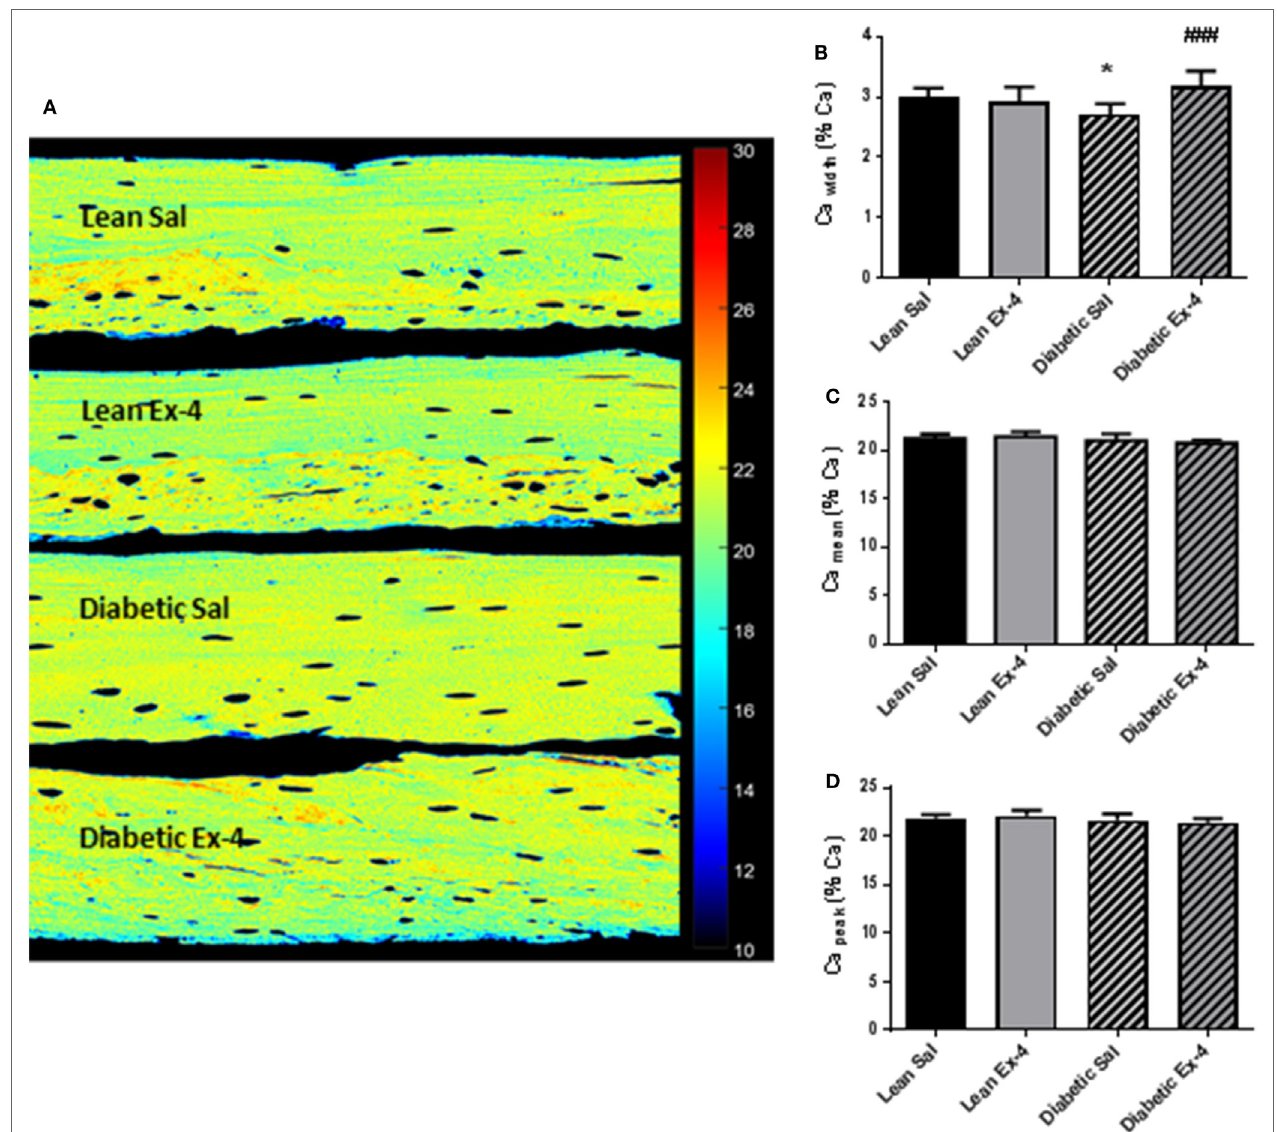
FigUre 6 | Effect of Exenatide on bone mineral density distribution (BMDD) in db/db and control mice. Quantitative backscattered electron imaging was employed to determine the BMDD in tibial methylmethacrylate-embedded blocks from 13-week-old db/db and lean mice treated with either Exenatide (10 μ g/kg/day) or saline. (a) Representative calcium (Ca) map. (B) Characterization of BMDD by Ca width. (c) Characterization of BMDD by Ca mean. (D) Characterization of BMDD by Ca peak. Bars represent mean ± SD of n = 10 mice/group, * P < 0.05 versus lean Sal; ### P < 0.001 versus diabetic